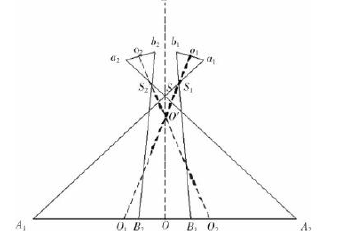
Figure 4. The ideal double-combined image